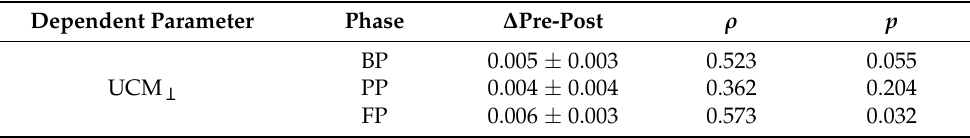
Table 1. Correlations ( ρ ) and p -values ( p ), as calculated by Spearman correlations, between the changes in UCM parameters and the Borg scale. ∆ Pre-Post values are given as mean ± standard deviation over the participants. BP, PP and FP signify the breaking, propulsion and flight phases, respectively. Dependent